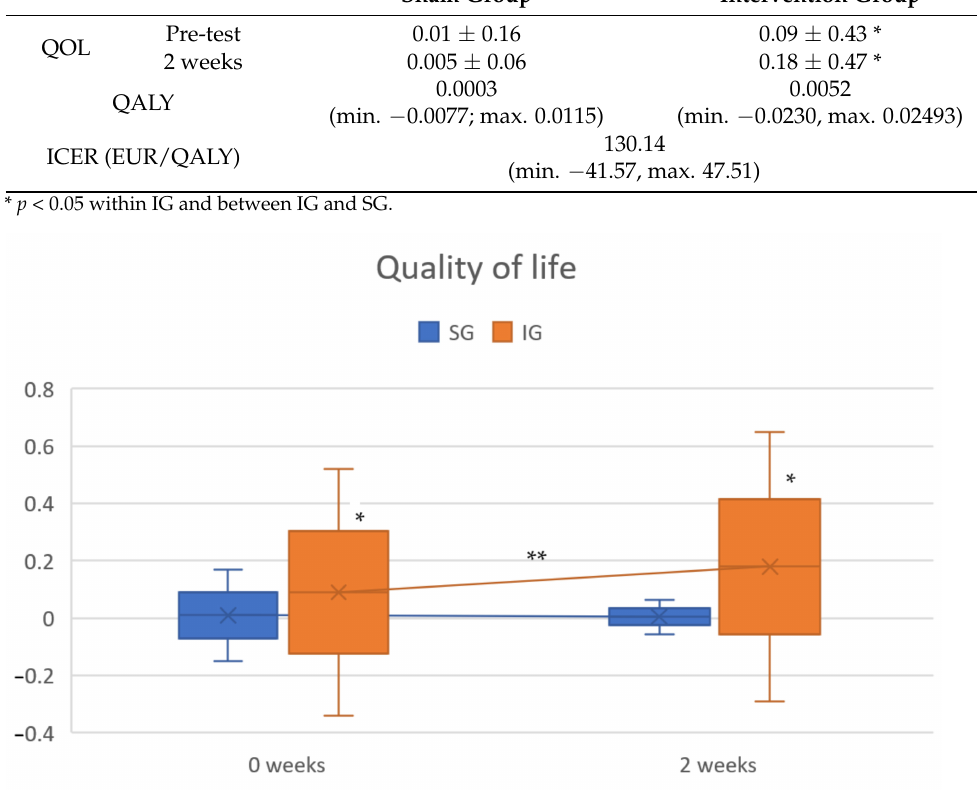
Figure 1. Variation of QOL during the study timeline. Abbreviations—IG: intervention group; SG: sham group. * p < 0.05 within IG; ** p < 0.05 between IG and